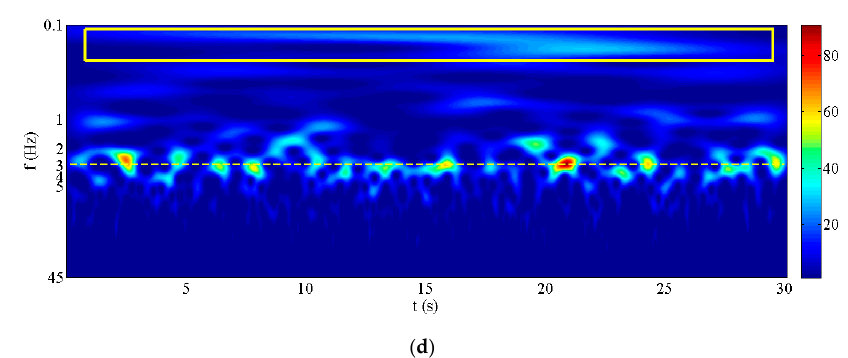
Figure 9. The wavelet spectrum of the time series signal of the streamwise fluctuating velocity at different positions of the turbine wake with configuration F, n = 5, c = 81mm: ( a ) schematic diagram, ( b ) P 201 , ( c ) P 301 , ( d ) P 503 .